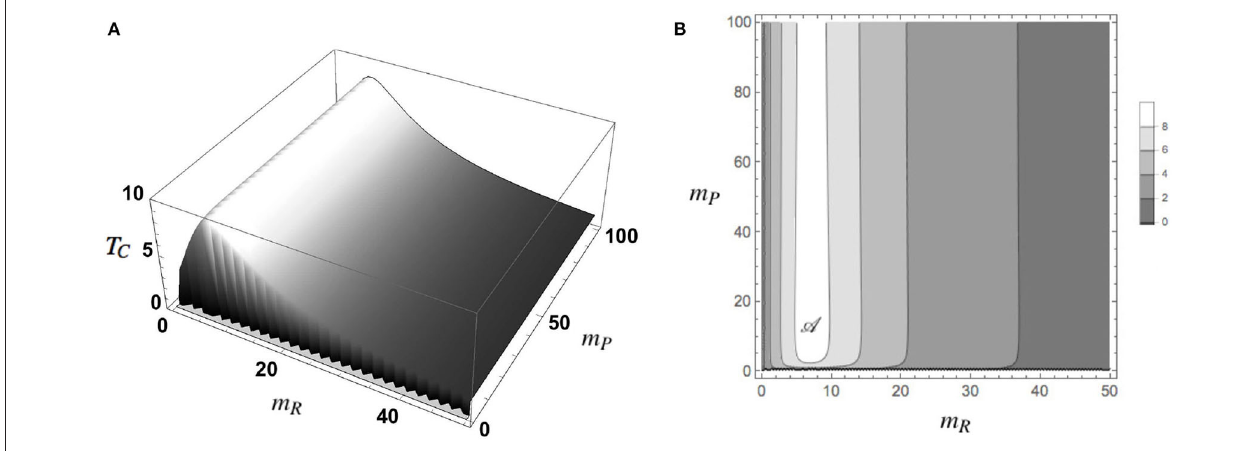
FIGURE 5 | Trophic cascade model with fixed body size of intermediate consumers m C = 10 ( kg ). (A) Graph of the trophic cascade intensity considering the body size of fixed intermediate consumers. (B) Graph of the level curves of (a). The other parameter values are: r 0 = 0.5, K 0 = 5, e C = 0.5, e P = 0.5, d C = 0.74, = 5, f = 700, f 0 = 0.5, and f ∞ = d P = 0.74, f CR PC